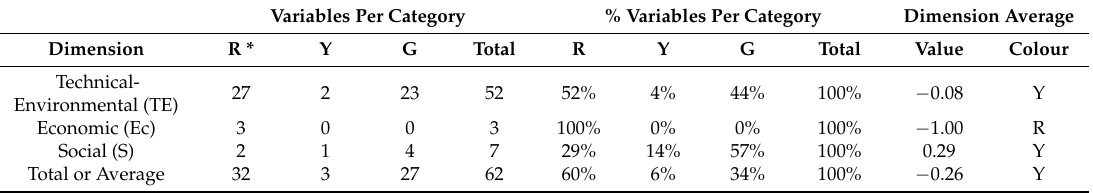
Table 8. Sustainability performance per dimension: Panajachel site. Variables Per Category % Variables Per